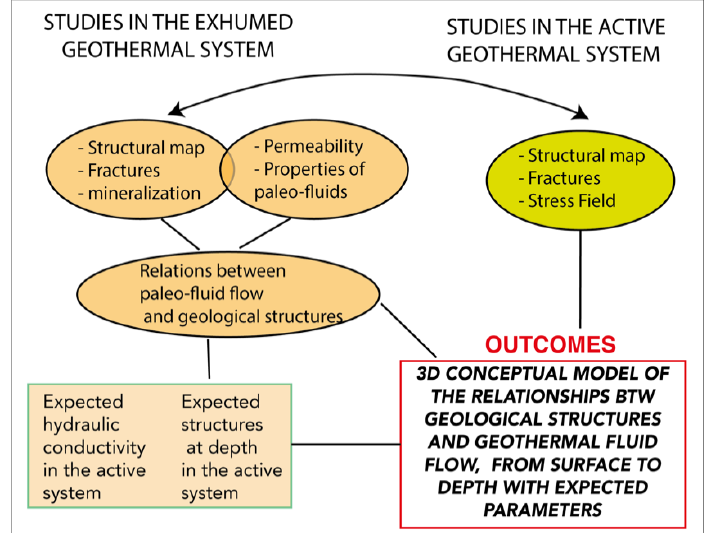
Figure 2. Sketch of the fieldwork and laboratory workflow to obtain a reliable 3D conceptual model, by transferring data from the exhumed geothermal system to the active one and by comparing fieldwork data from the active system with those from the exhumed system.